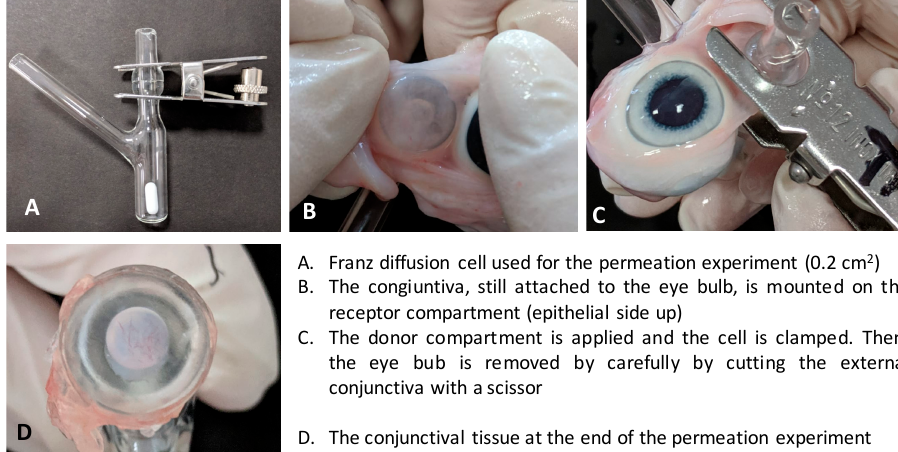
Figure A1. Setup of the transconjunctival permeation experiment. ( a ) Franz diffusion cell used for the permeation experiment (0.2 cm 2 ); ( b ) The conjunctiva, still attached to the eye bulb, is mounted on the